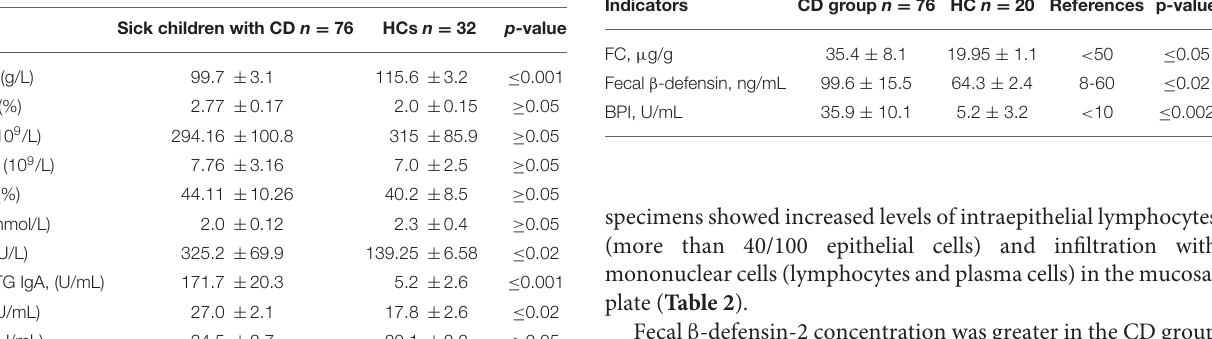
TABLE 1 | Biochemical and serologic test-results of patients with celiac disease compared to those of healthy controls ( n = 76). Signs